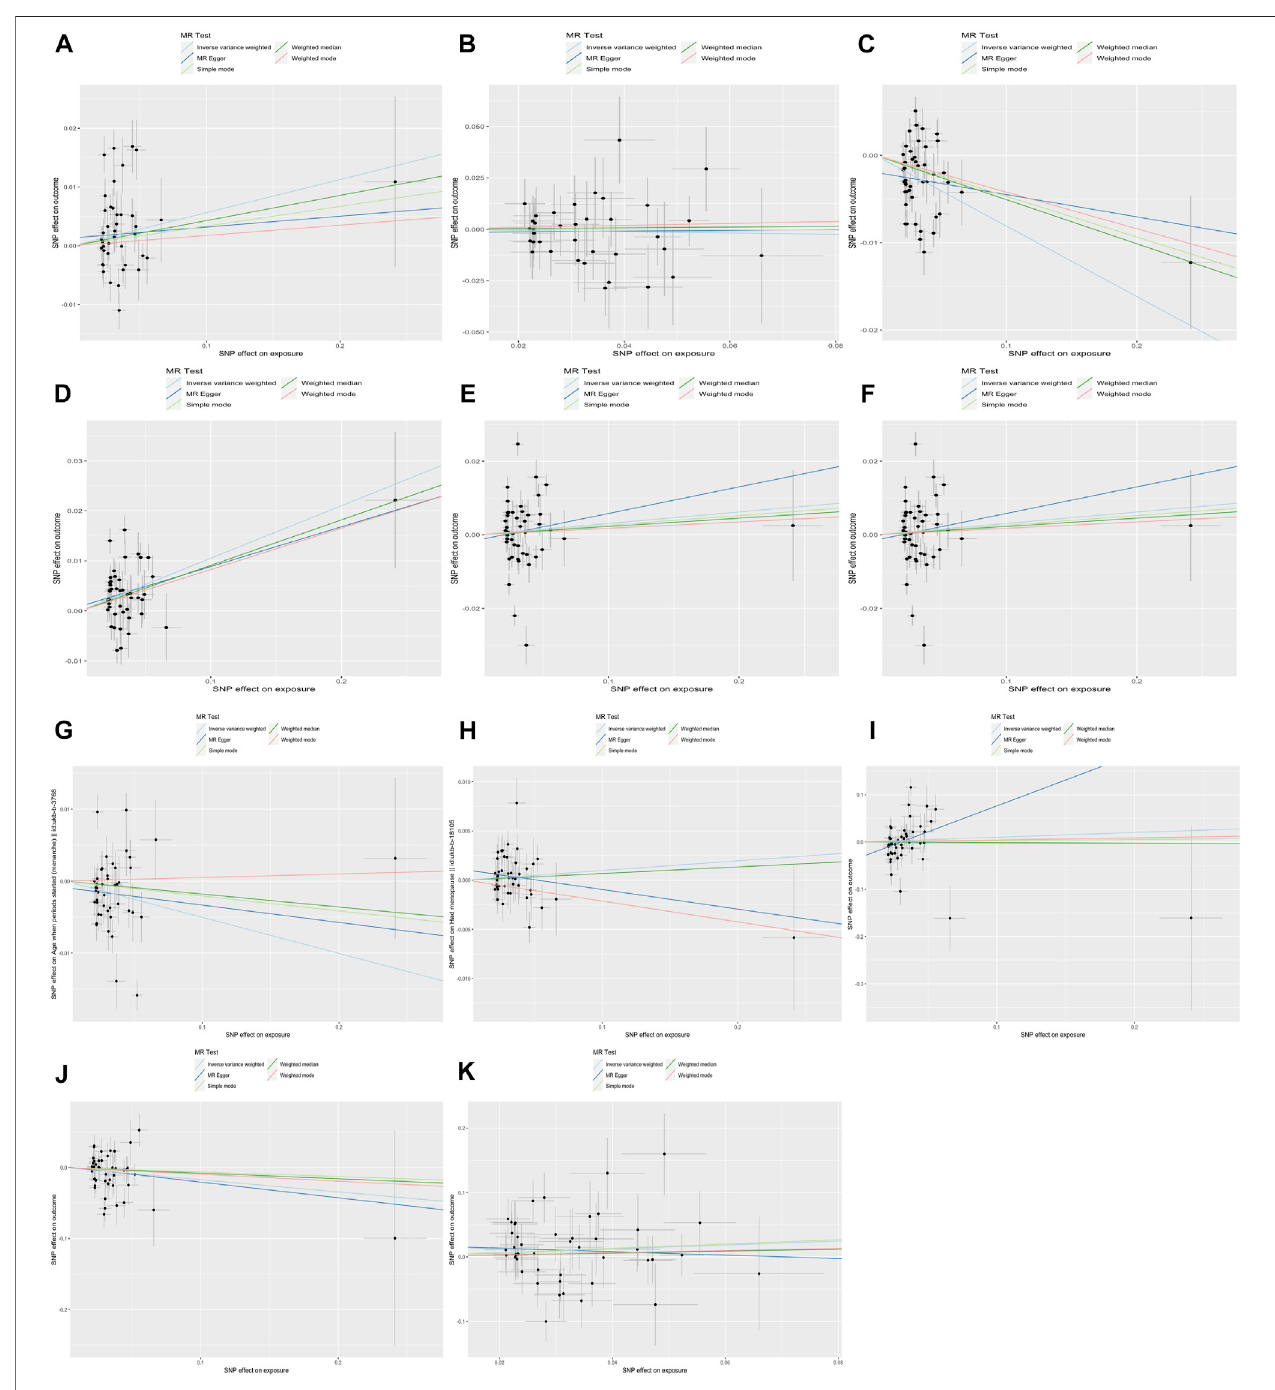
FIGURE 3 | The results of the scatter